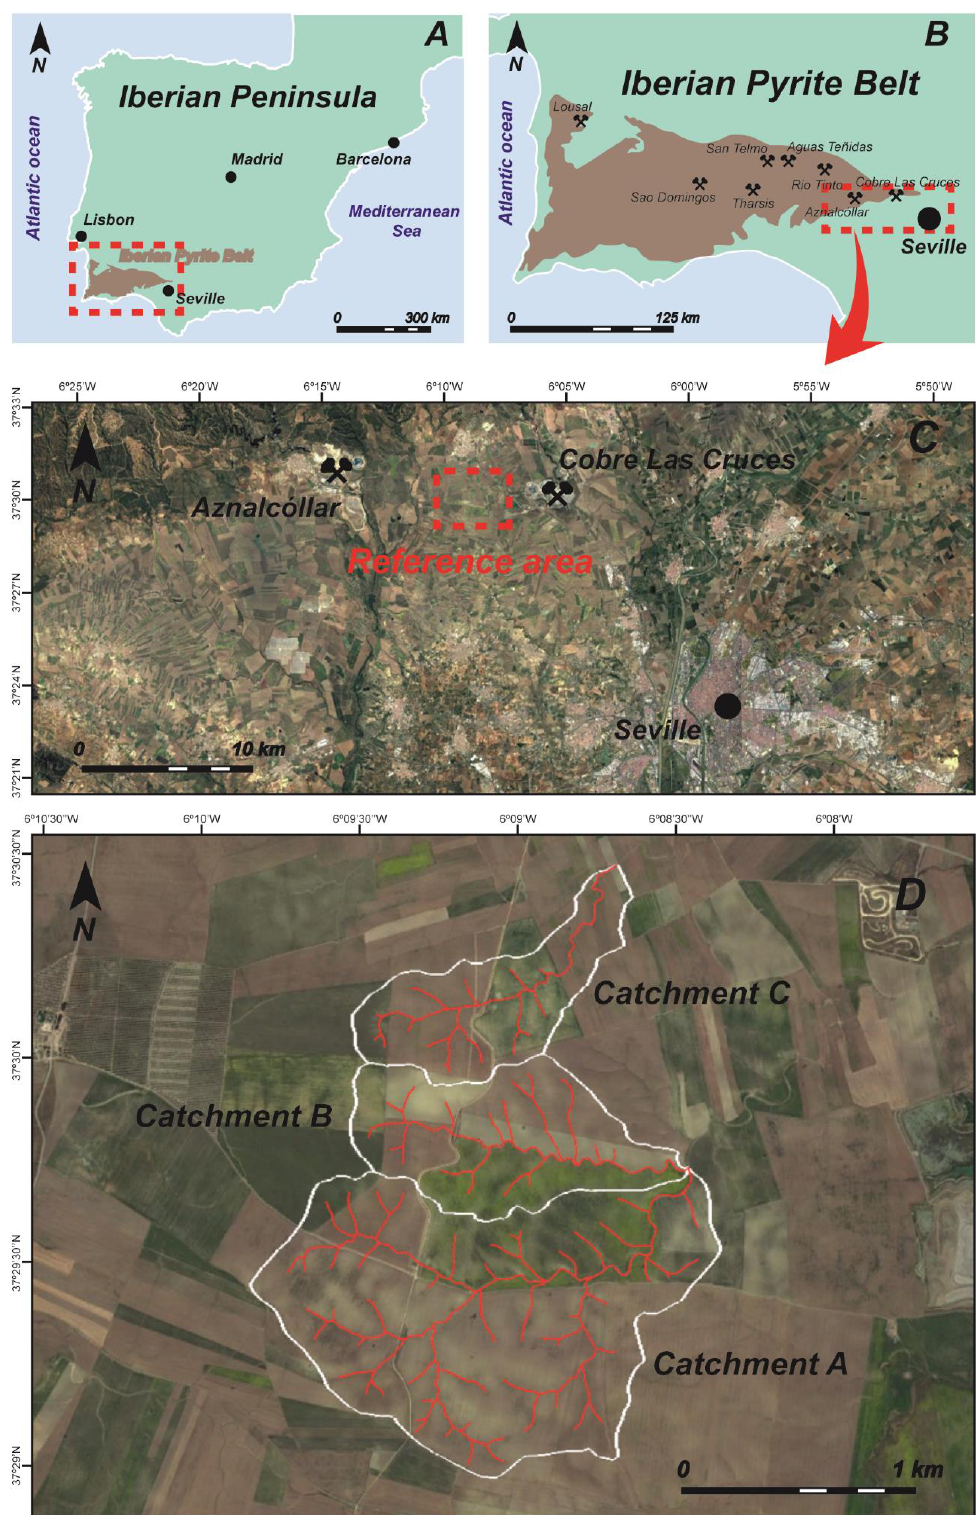
Figure 1. ( A ) Location of the Iberian Pyrite Belt (IPB) in the Iberian Peninsula; ( B ) the IPB and some of its most outstanding metallic mines. The study area is located 18.5 km northwest of Seville (Spain), in the south-eastern margin of the IPB. ( C , D ) Detailed view of the study area and catchments A, B, and C selected for this study.